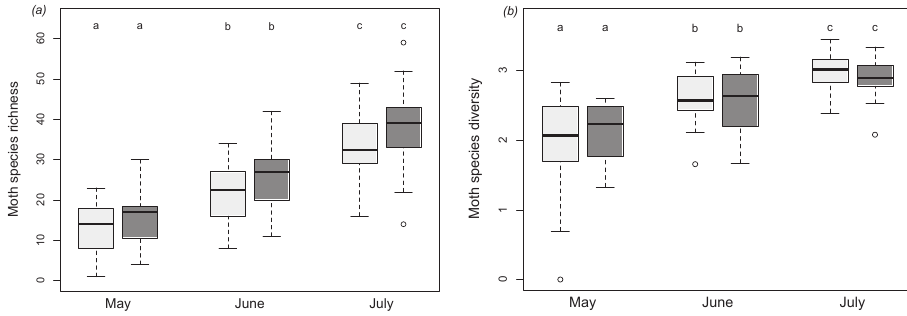
Figure 3. Boxplots of species richness a and species diversity b in relation to occupied (dark grey) and abandoned sites (light grey) from May to July. Boxplots visualize the 25%, 50% (bold line) and 75% limits where the whiskers indicate the 10% and 90% deciles. Open dots indicate outliers. Different letters depict statistically significant